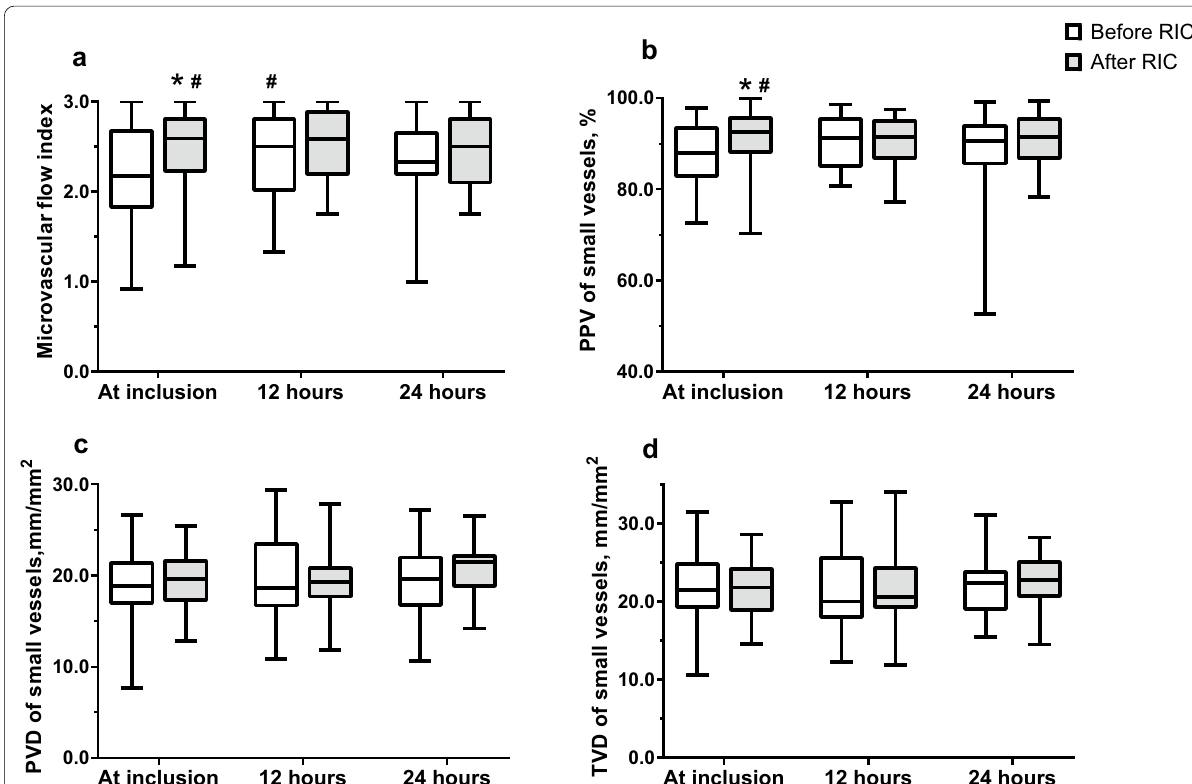
Fig. 1 Microcirculatory parameters before and after RIC over 24 h. a Microvascular flow index; b proportion of perfused vessels (PPV) of small vessels; c perfused vessel density (PVD) of small vessels; d total vessel density (TVD) of small vessels. * p < 0.05 significant difference before and after remote ischemic conditioning (RIC). # p < 0.05 compared with the historical control